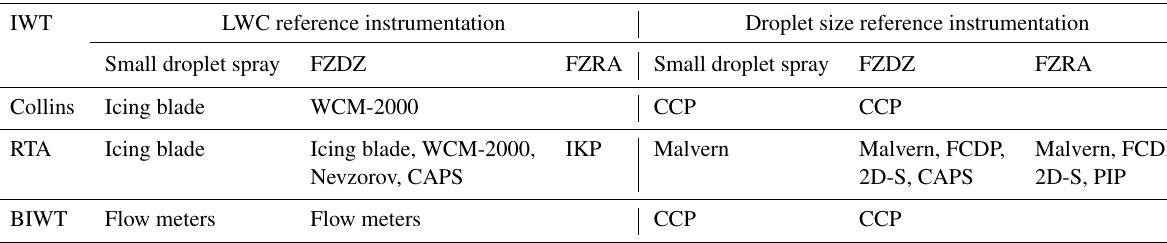
Table 2. Tunnel reference instrumentation used by the IWT operators.